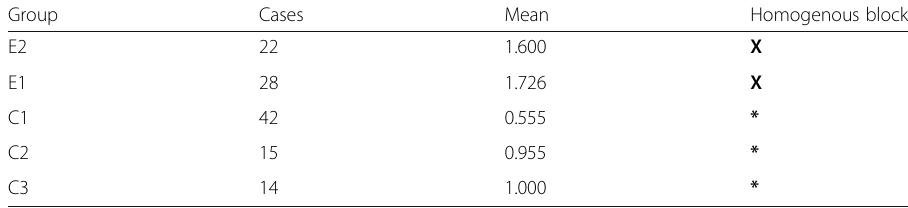
Table 7 Homogeneous blocks of progress (post-treatment) Group